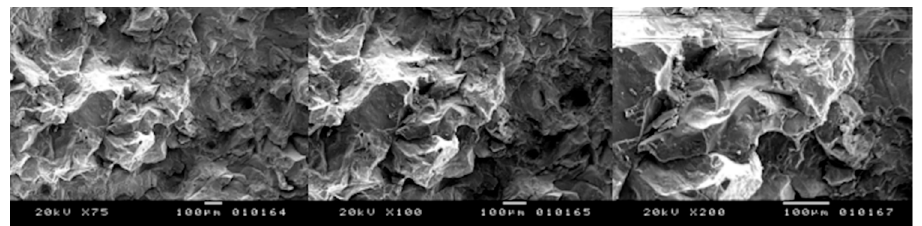
( centre ) X100; ( right ) X500.